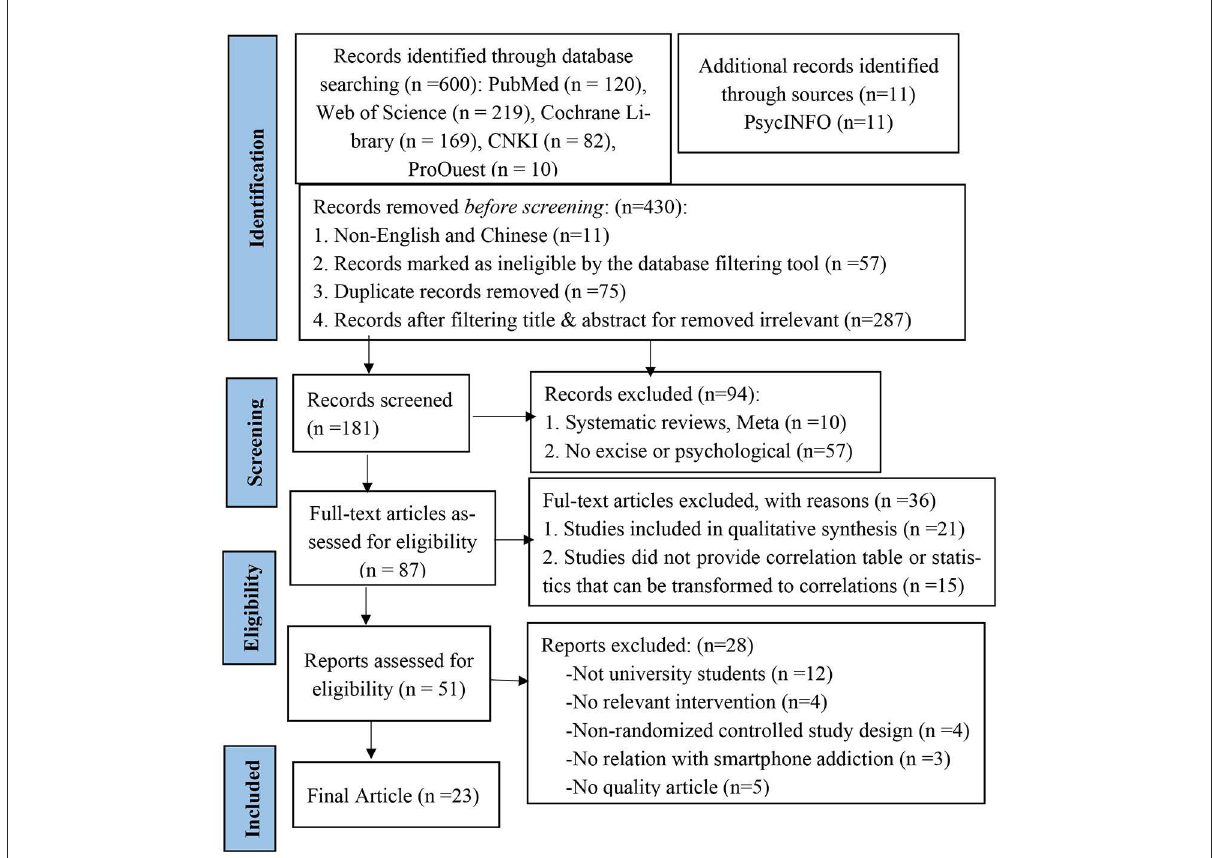
FIGURE1 PRISMA flow chart of the study selection